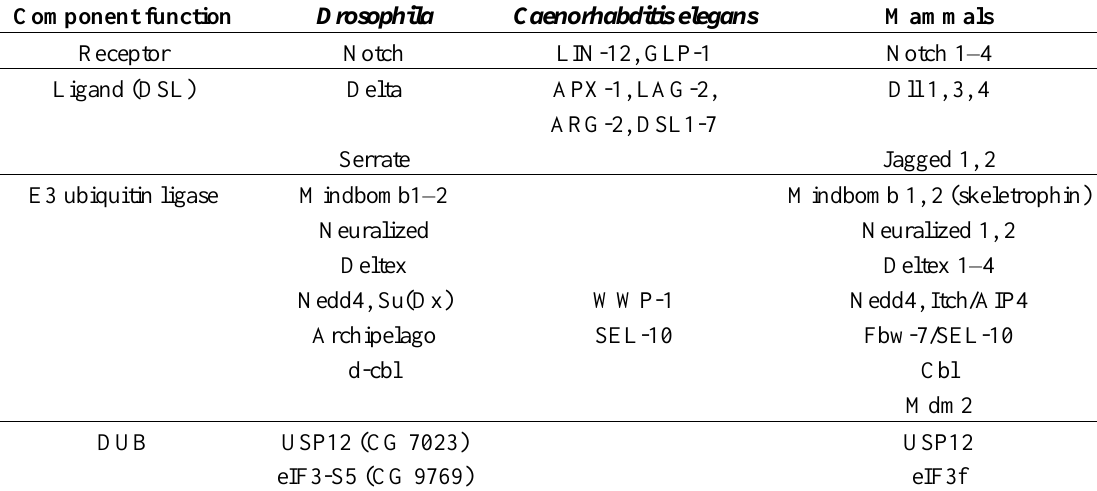
Table 1. Receptors, ligands, E3 ubiquitin ligases and deubiquitinating enzymes (DUBs) of the Notch